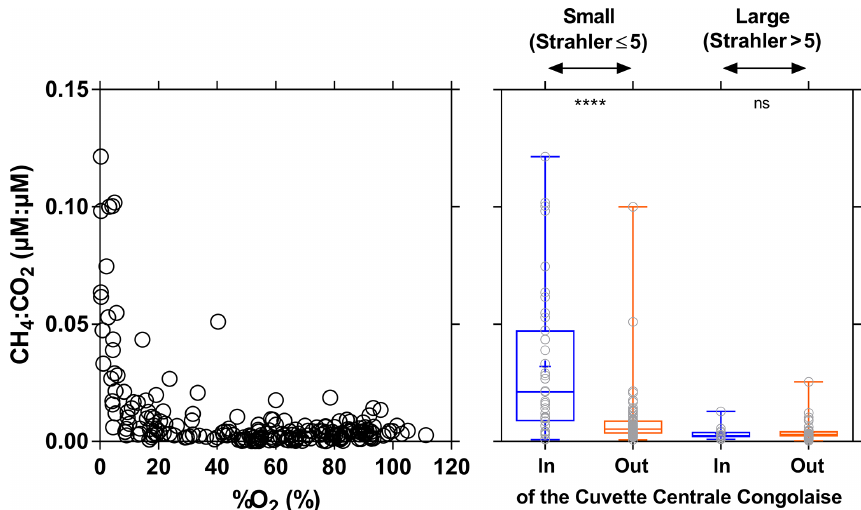
Figure 14. Ratio of dissolved CH 4 and CO 2 concentration (µmol:µmol) plotted as a function of O 2 saturation level (%O 2 in %) and plotted in box plots draining and not draining the Cuvette Centrale Congolaise for small and large systems (Strahler stream order 5 ≤ and >5, respectively) (3–19 December 2013; 10–30 June 2014). The box represents the first and third quartile, the horizontal line corresponds to the median, the cross corresponds to the average, the error bars correspond to the maximum and minimum, and the symbols show all data points. A Mann–Whitney test was used to test statistical differences: ns = not significant; ∗∗∗∗ = p< 0 .